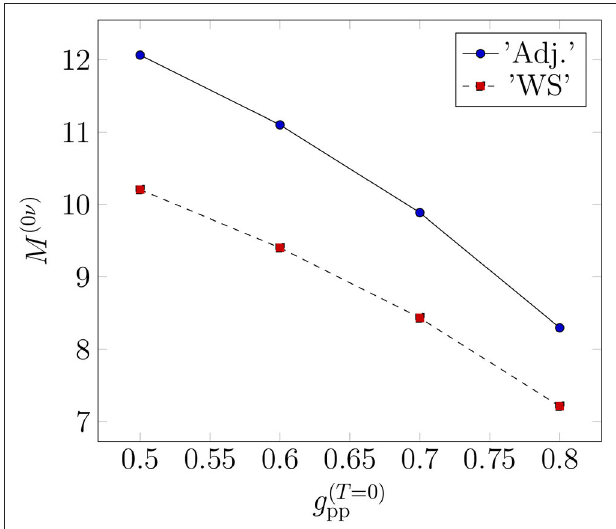
FIGURE 5 | Dependence of the 0 νβ + β + -decay NME on the isoscalar part of the particle-particle parameter g pp in the two different single-particle bases.